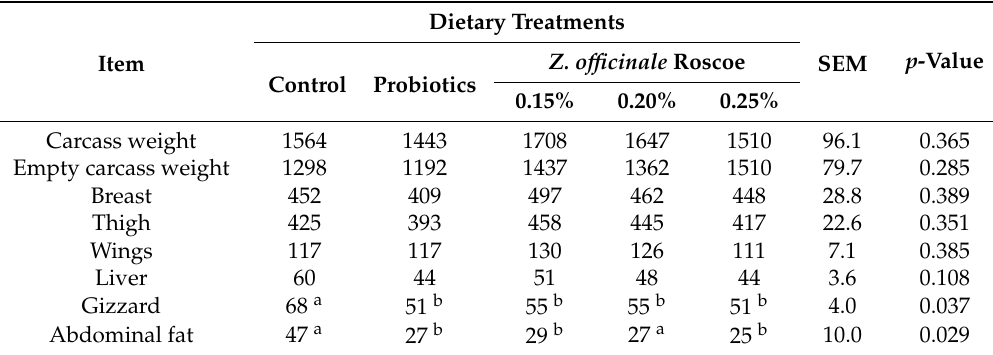
Table 3. Effects of experimental diets on broiler carcass components